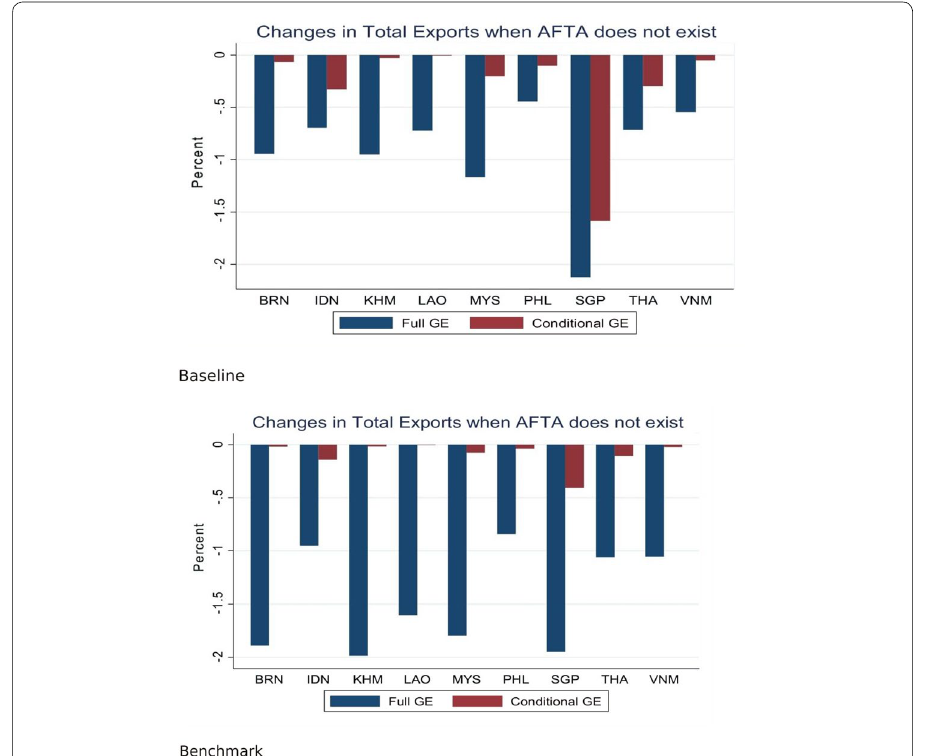
Figs. 1 and 2 Conditional and full GE impact of AFTA on member countries’ export (baseline and